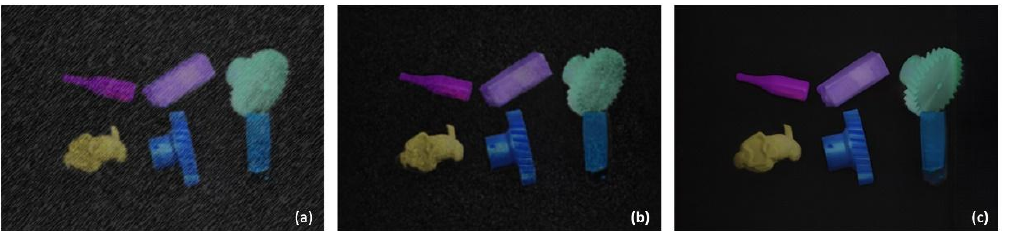
Figure 18. Output image comparison ( a ) U-Net model; ( b ) basic SpecToPoseNet model; ( c ) final SpecToPoseNet models.